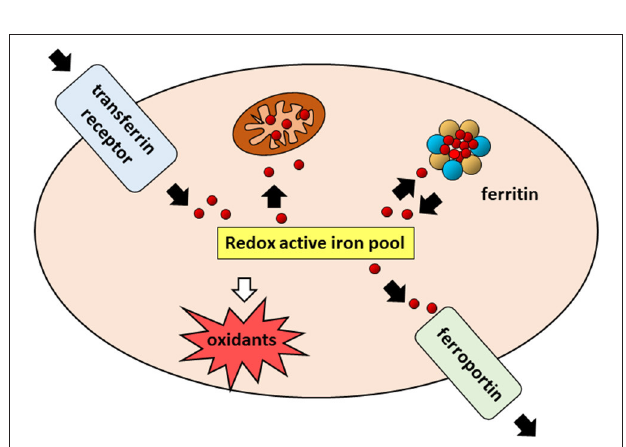
FIGURE 2 | Cellular iron pathways in a nutshell. Transferrin bound iron, internalized through endocytosis of the transferrin receptor (TfR1), enters a pool of redox-active iron whose concentration is kept under control by mechanisms ensuring that the iron which is not used for biochemical processes, particularly in mitochondria, is either safely stored in cytoplasmic ferritin or exported by ferroportin.